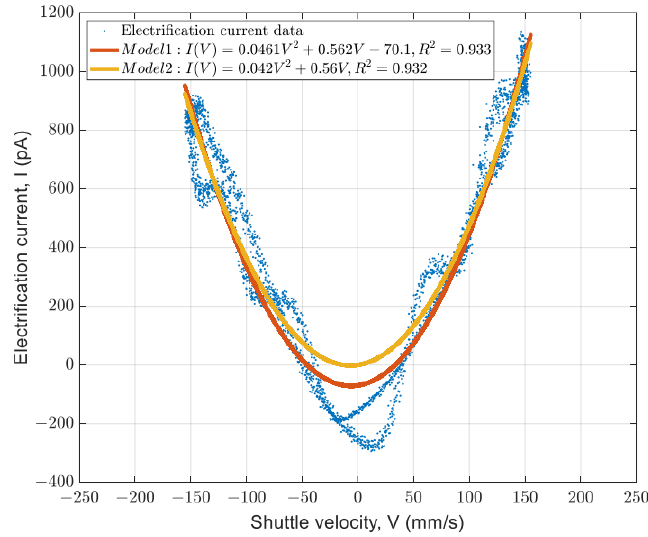
Figure 17. Dependence of electrification on intermittent shuttle speed and fitted second order polynomial models. Shuttle frequency is 4